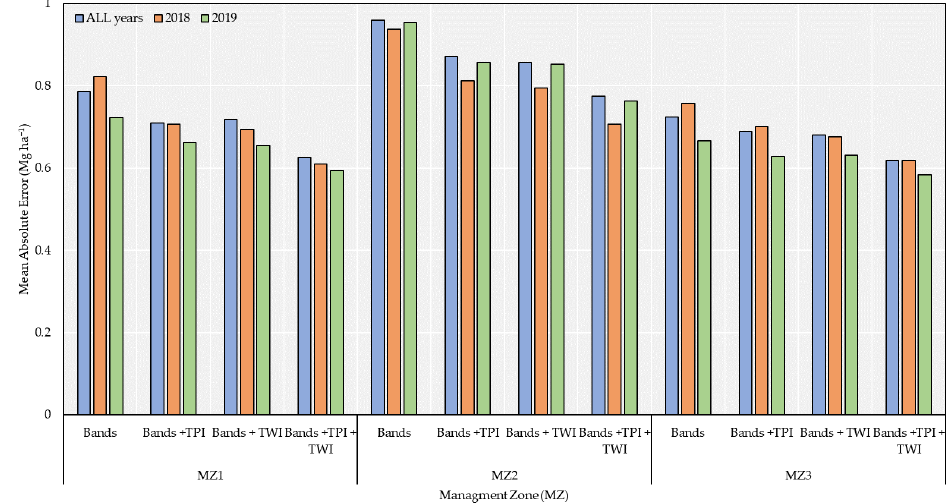
Figure 8. Accuracy (MAE) of the validation phase of the model developed using whole-field data in three scenarios (2018, 2019, and all years combined); the accuracy is showed in each management zone. TWI: topographic wetness index; TPI: topographic position index; MZ1, MZ2, and MZ3: management zones one (high yield), two (low yield), and three (intermedium yield), respectively. To determine whether the association between topographical indices and spectral bands could increase the accuracy of the yield forecasting, we calculated the relative error of the models when only spectral bands were used as features (Figure 9). Analyzing all scenarios, isolated seasons (2018 and 2019), and combined seasons, including spectral bands + TWI + TPI as features, the models obtained a better accuracy, whereas accuracy was higher for site-specific models (Figure 8). For the scenario of the isolated season and site-specific models, the models using spectral bands + TWI and spectral bands + TPI showed a similar increase in accuracy to that of the models using only spectral bands.